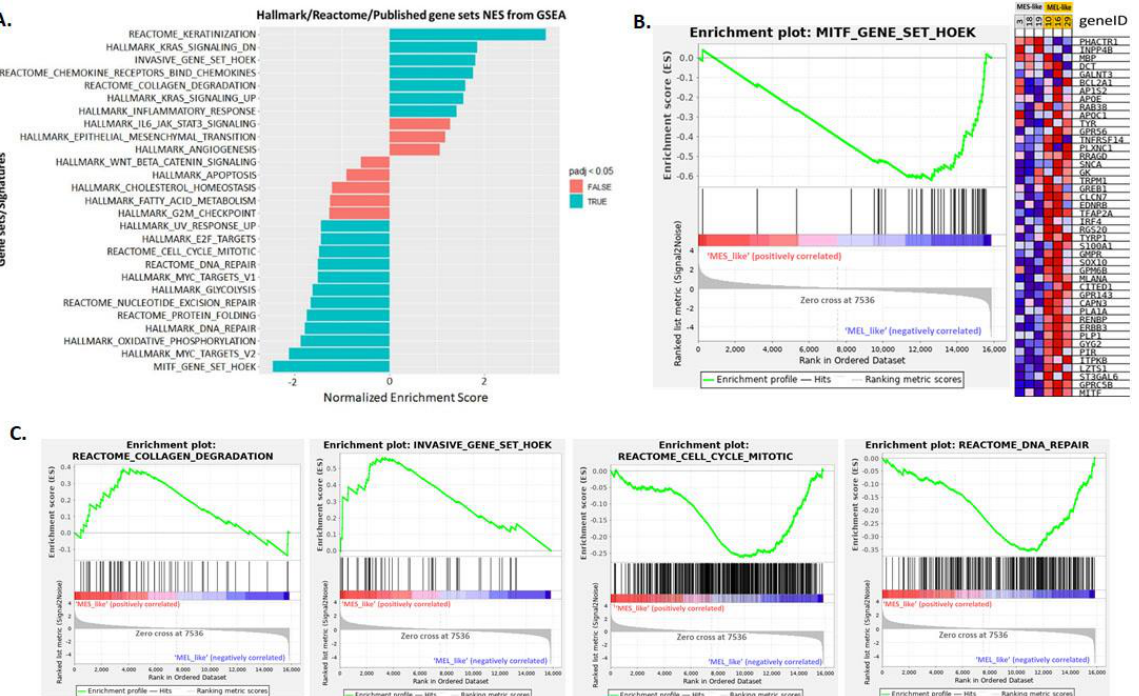
Figure 8. Gene set enrichment analysis (GSEA) results of MES-like versus MEL-like melanoma sample comparison. ( A ). Bar plot showing selected top enriched gene sets/pathways as derived from GSEA based on the differential expression analysis of MES-like versus MEL-like tumour melanoma samples. Bars in blue indicate significant enrichment at p-adj (FDR) <5%, bars in red represent gene sets with FDR >5% and a nominal p -value < 5%. A positive normalised enrichment score (NES) value indicates enrichment in the MES-like phenotype, a negative NES indicates enrichment in the MEL-like phenotype. ( B ). Gene set enrichment plot of MITF melanoma signature (Hoek et al. 2008), enriched in MEL-like vs. MES-like GSEA showing the profile of the running ES and positions of gene set members on the log2FC (Fold Change) rank-ordered list. The signal2Noise metric is graphed for each correlated gene in the ranked dataset. Heat map of 44 MITF signature genes (for each phenotype in the comparison of MES-like (grey column) vs. MEL-like (orange column). Normalised expression values are represented as colours and range from red (high expression), pink (moderate), light blue (low) to dark blue (lowest expression). ( C ). Four GSEA enrichment plots for representative molecular signatures (Cell-cycle, DNA-repair, Collagen-degradation, Tumour invasive signature) enriched in MES- and MEL-like tumours are shown. The top part of each GSEA plot shows the running enrichment score for validated genes specific for a particular pathway/signature as it moves down the ranked list. The bottom part of each plot shows the value of ranking matrices as it moves down the list of ranked genes. The red horizontal bar that terminates with a blue colour indicates a shift from positively correlated genes (red) to negatively correlated genes (blue). The y -axis represents enrichment score (ES) and the x -axis shows differential expressed genes (vertical black lines) represented in different pathways.